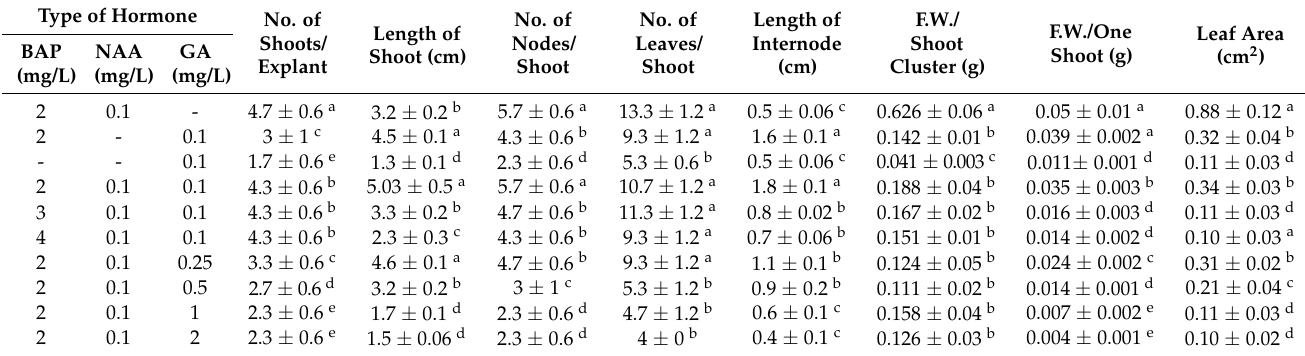
Table 6. Effect of different concentrations of GA alone or in combination with 0.1 mg/L NAA and different concentrations of BAP in semisolid MS medium on in vitro shoot multiplication and growth of paulownia.